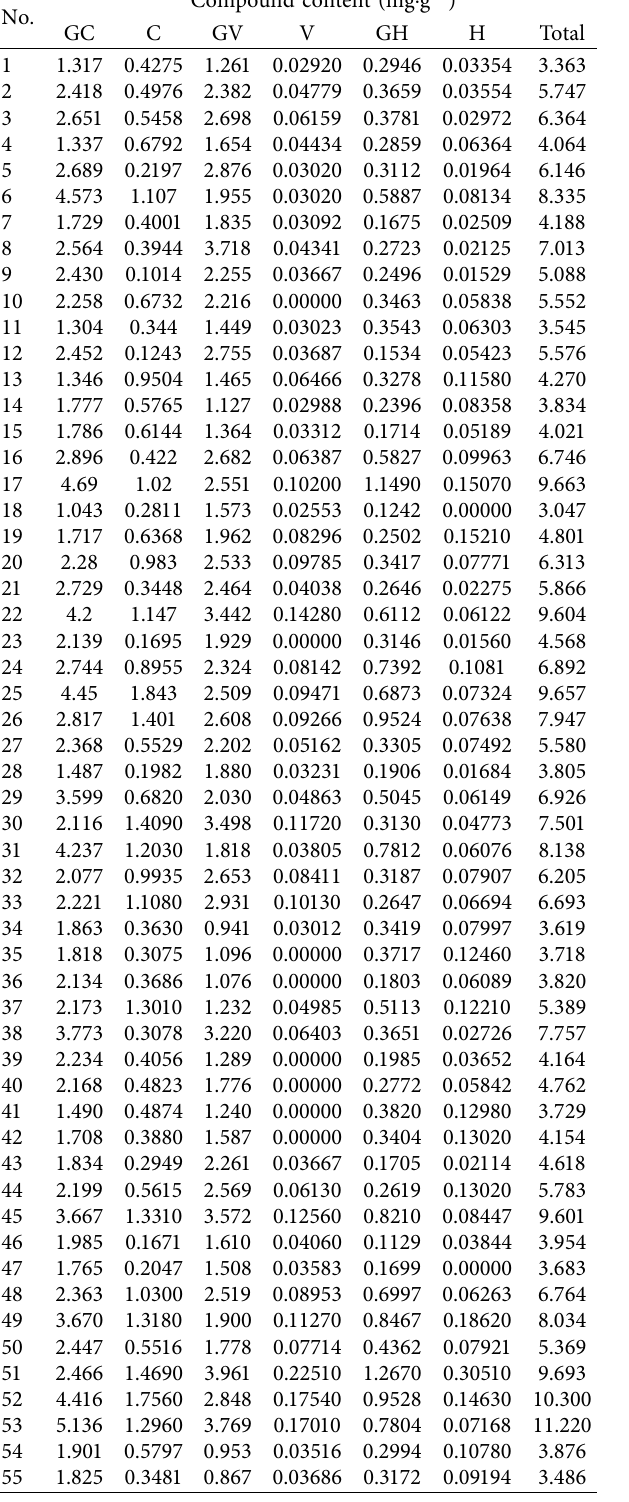
Table 4: Content of six chromone compounds in 55 batches of commercial SR.